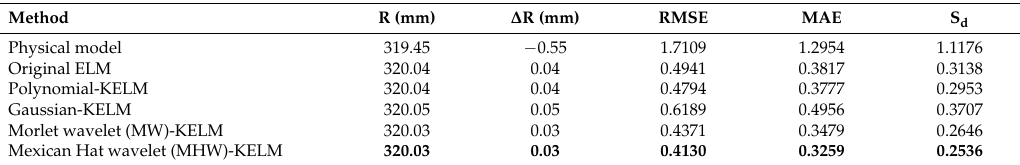
Table 2. Results of the circle testing data set.